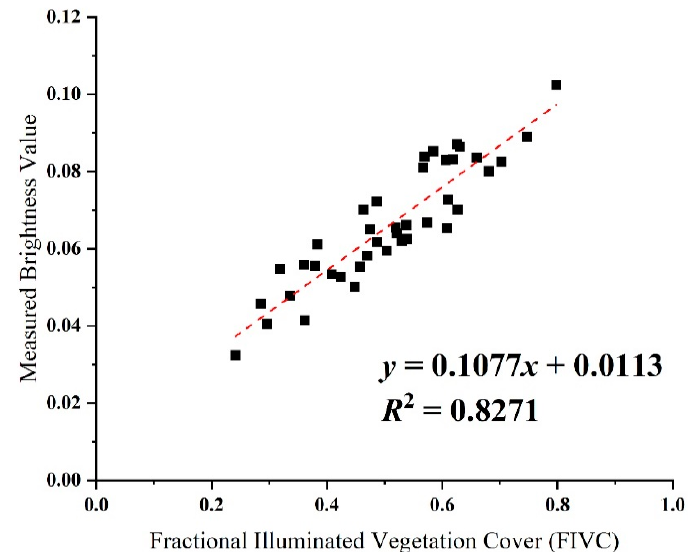
Figure 10. Scatterplot of FIVC and measured brightness values for typical vegetation samples with different illumination/shadow proportions.